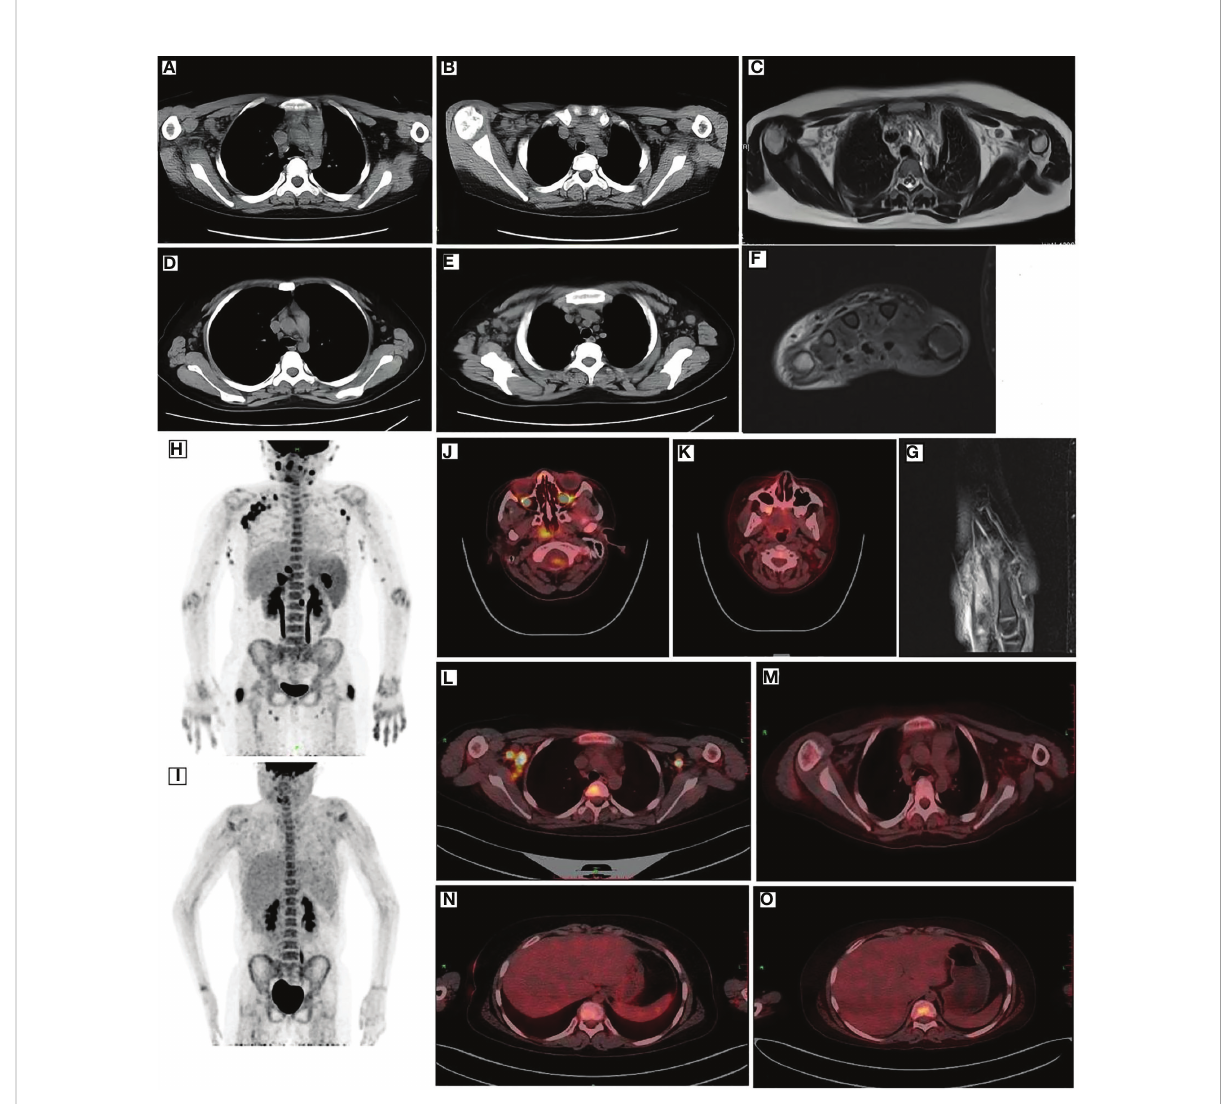
FIGURE 1 Imaging of the patient. CT (A, B) , MRI (C) , and PET (L) revealed multiple enlarged lymph nodes in the mediastinum and axilla with elevated glucose metabolism. After remission, CT (D, E) and PET (M) showed smaller lymph nodes than before and decreased glucose metabolism. Before treatment, PET (H) depicted multiple lymph node enlargements and tissue involvement with abnormally increased glucose metabolism. After remission, PET (I) revealed a signi fi cant reduction in the original lymph node and tissue lesions and decreased glucose metabolism. After remission, PET (J, L) indicated elevated FDG metabolism in the posterior nasopharyngeal wall and central bone marrow (K, M) , suggesting normal FDG metabolism. MRI (F, G) indicated edema around the dorsal extensor tendons of the 2nd to 5th metacarpals of the right hand and soft tissue swelling around the right wrist. PET (N) depicted increased liver volume. Moreover, repeat PET (O) after remission indicated increased liver volume and diffused hypodensity of the liver parenchyma. CT, computed tomography; MRI, magnetic resonance imaging; PET, positron emission